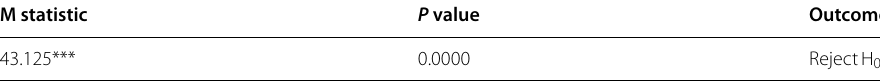
Table 6 Weak identification test: Anderson canon. Corr. LM